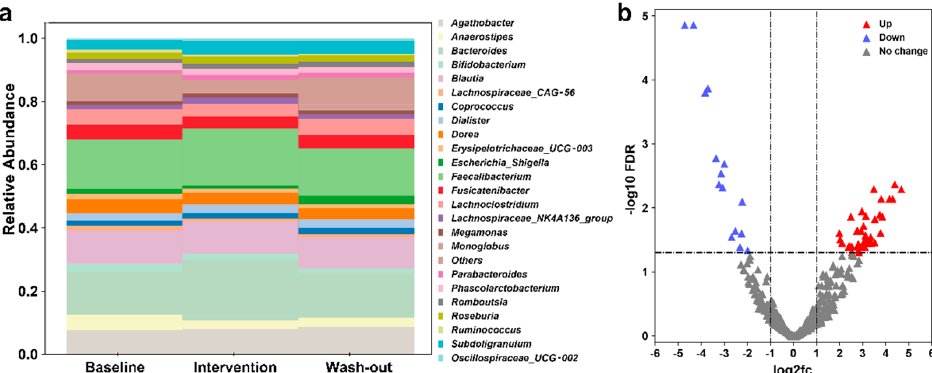
Figure 2. Effects of H. erinaceus intervention on gut microbes. ( a ) A chart showing the 25 most abundant bacterial genera (relative abundance). ( b ) Gut microbiomes with H. erinaceus intervention are enriched and depleted for certain amplicon sequencing variants (ASVs) compared to baseline. The red points are the ASVs that are significantly upregulated, the purple points are the ASVs that are significantly downregulated, and the gray points shows ASVs with no significant changes.